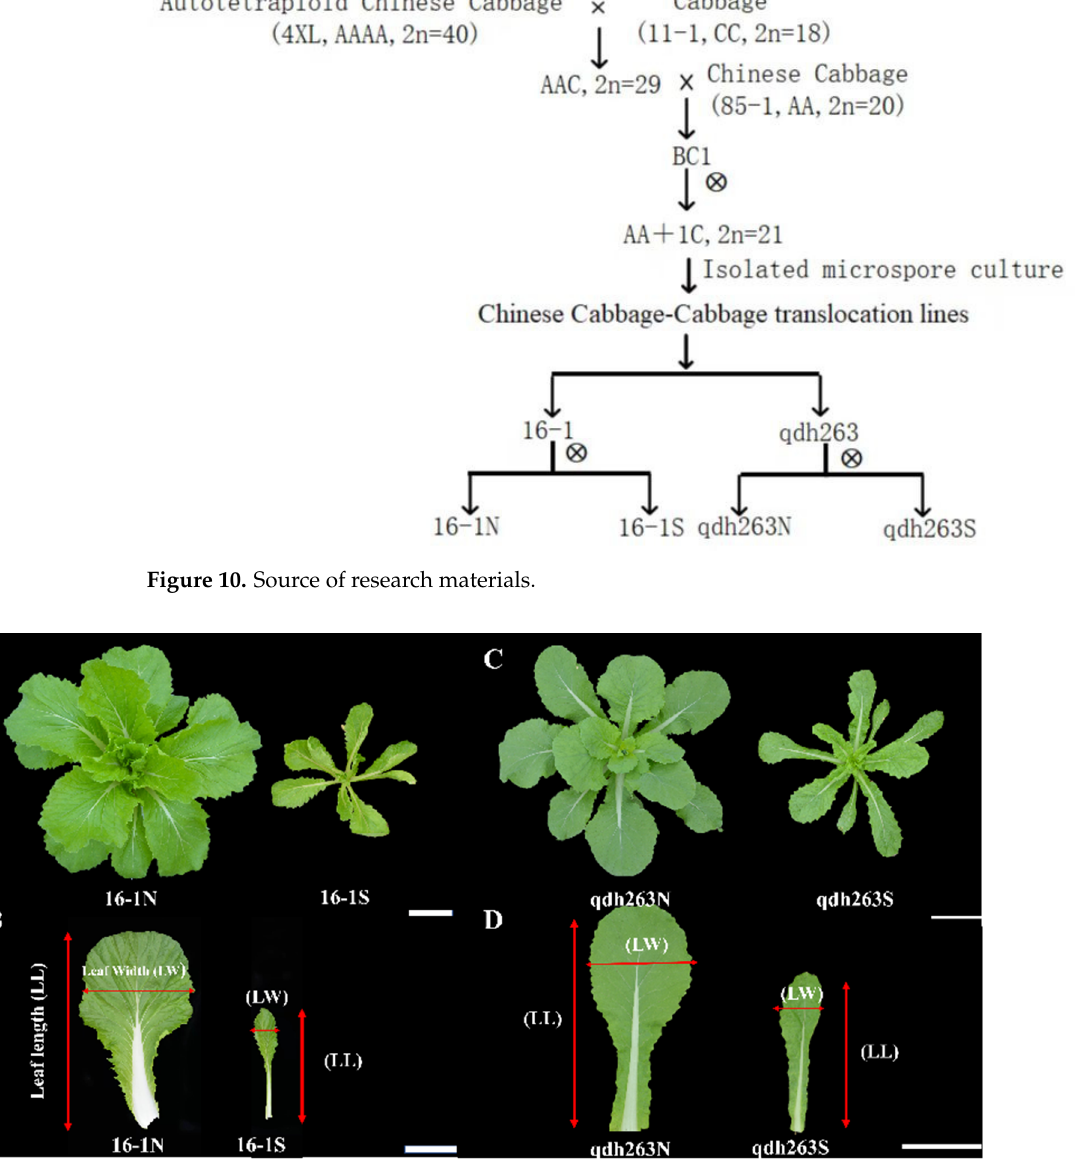
Figure 11. Chinese cabbage-cabbage translocation lines. ( A ) 16-1 translocation line; ( B ) leaves from 16-1 translocation line Normal (N) verses Small (S), ( C ) qdh-263 translocation line ( D ) qdh-263 translocation line leaves Normal (N) vs. Small (S)